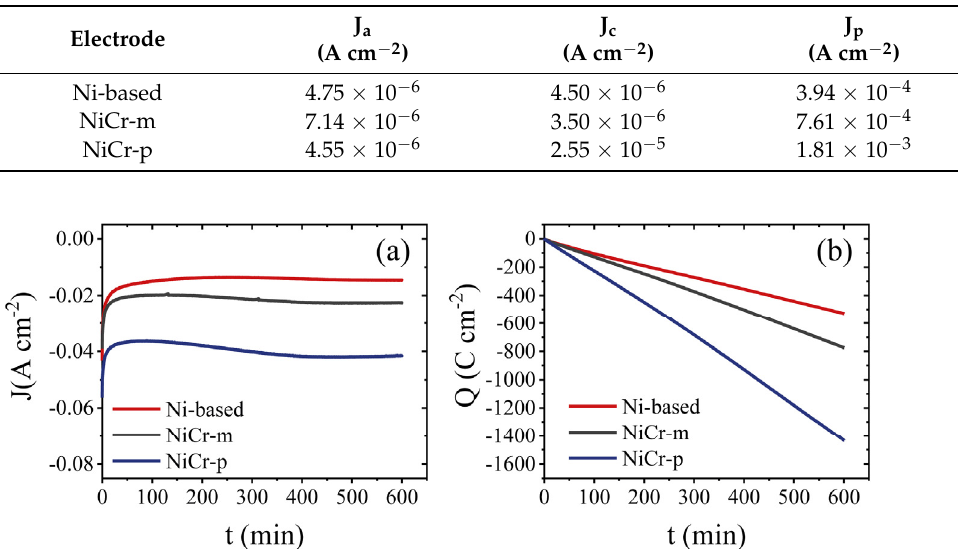
Table 3. Activation energy values are calculated at equilibrium.